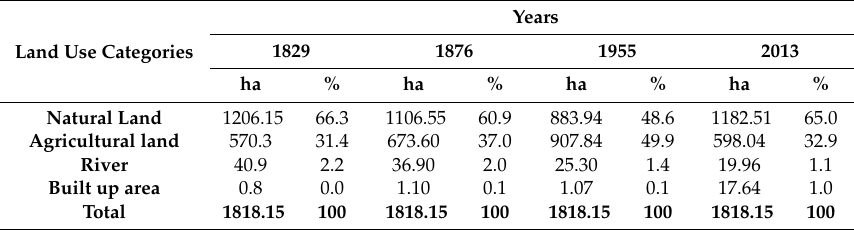
Table 1. Analysis of land use categories in percentage (%) and surface (ha).